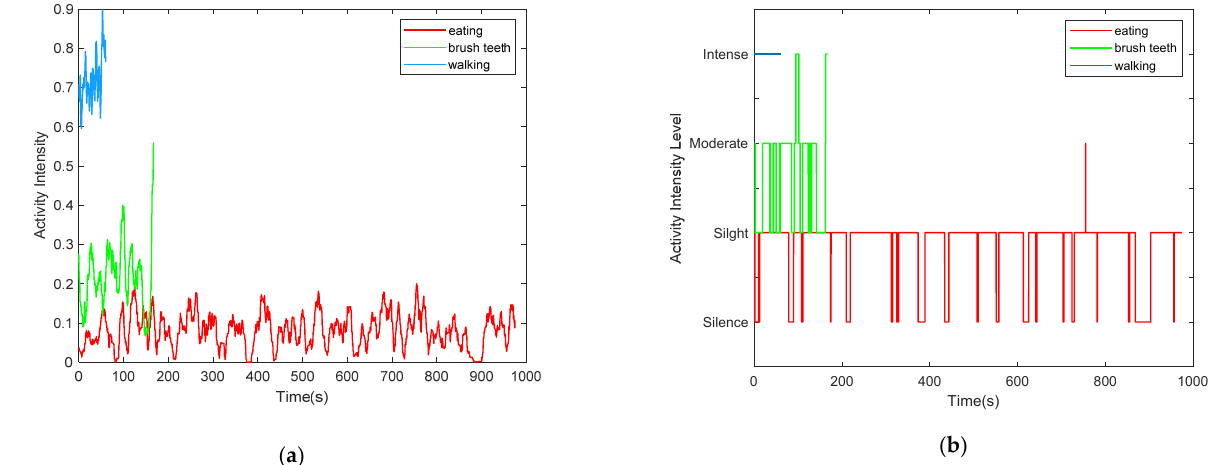
Figure 17. The averaged activity intensity and the corresponding activity level of the three types of daily activities. ( a ) The averaged activity intensity of the three types of daily activities; ( b ) The activity level of the three types of daily activities.